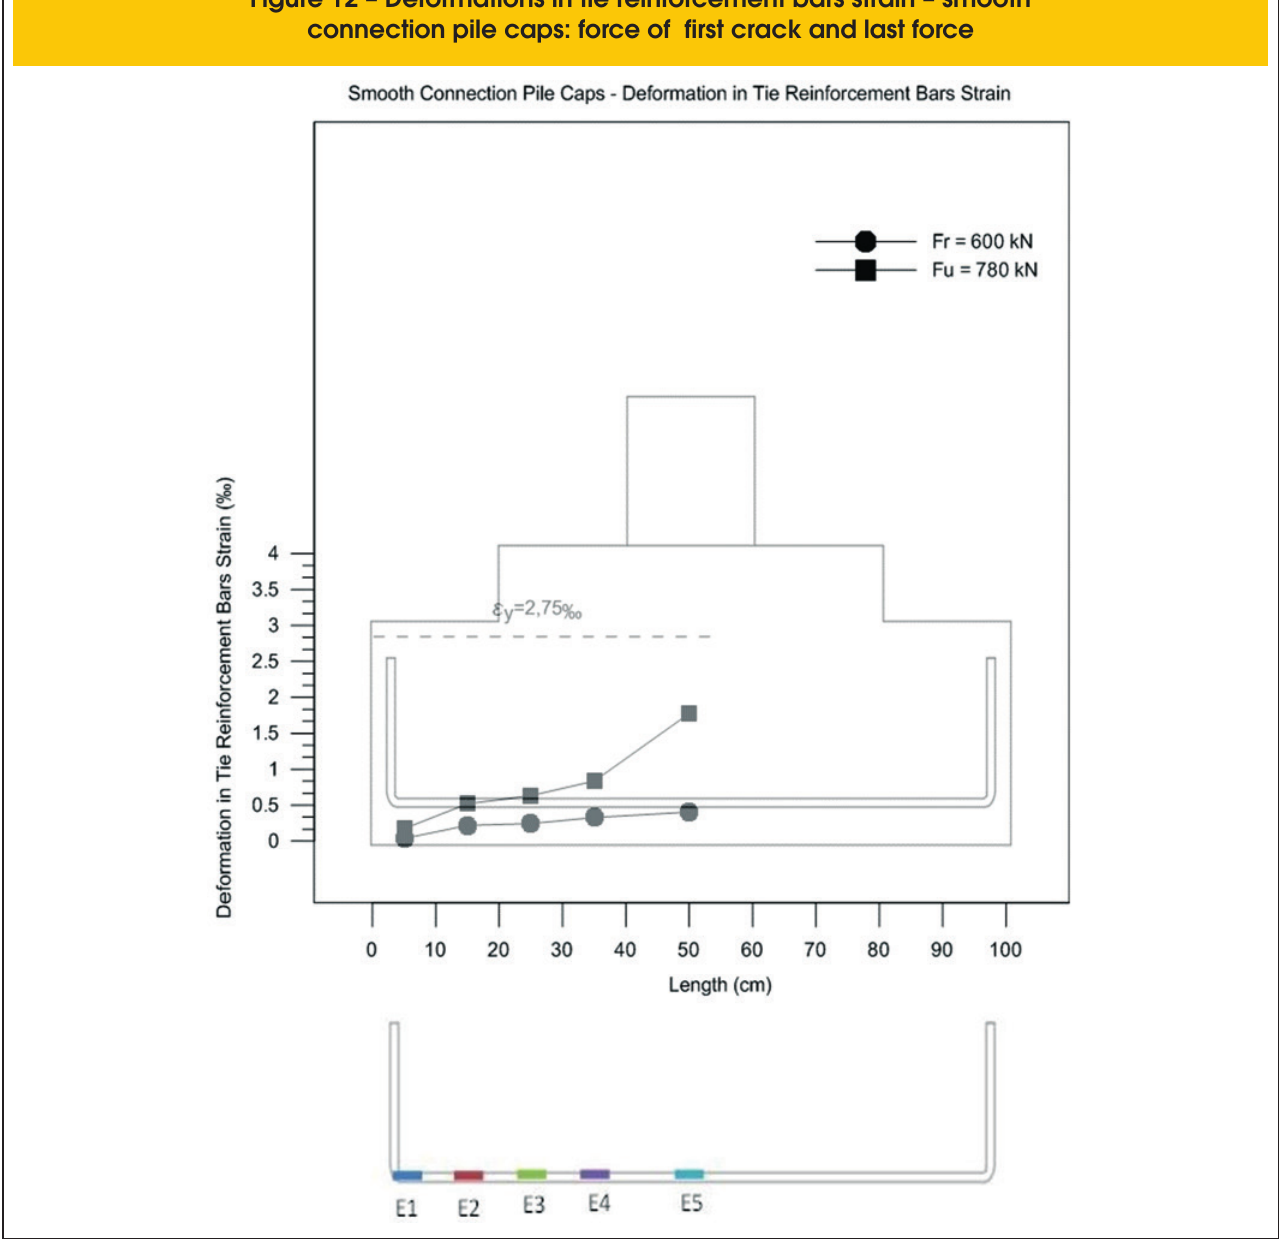
Figure 12 – Deformations in tie reinforcement bars strain – smooth connection pile caps: force of first crack and last